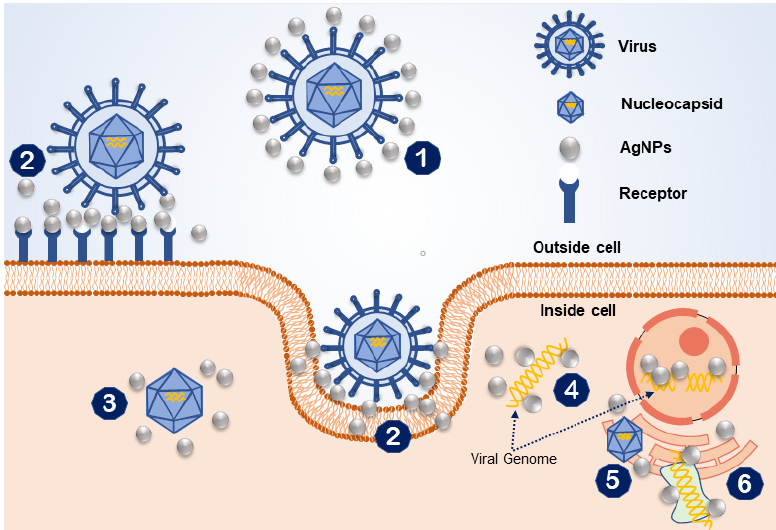
Figure 3. An illustration of the possible antiviral mechanisms of silver nanoparticles (AgNPs): (1) interaction of AgNPs with the viral surface; (2) interface with the cell membrane while blocking the viral attachment; (3) inhibition of cellular pathways of the virus; (4) interaction with viral genome; (5) interaction to inhibit viral genome replication; (6) inhibition of cellular factors (i.e., protein synthesis) necessary for viral replication.